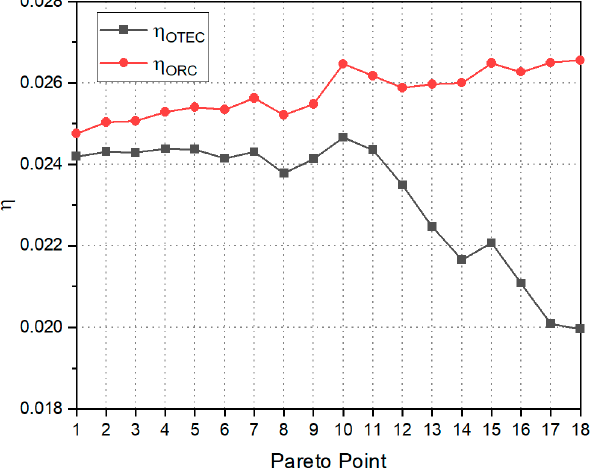
Figure 6. The thermal efficiency of the ORC and OTEC at the Pareto frontier point.